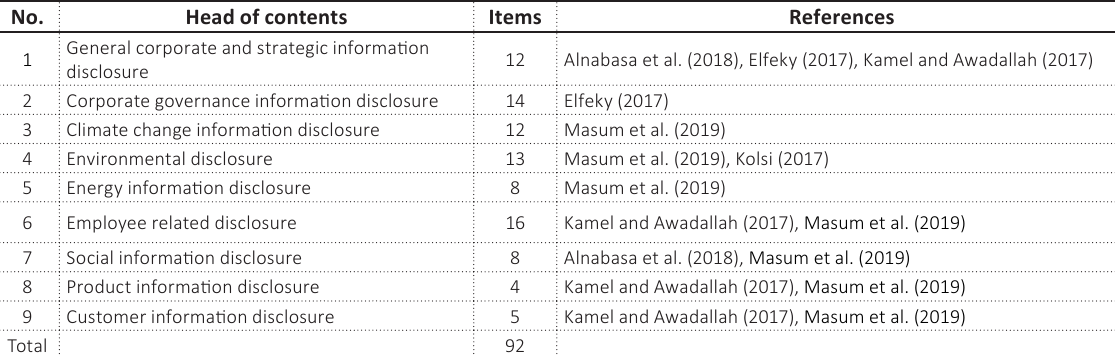
Table A1. Content analysis of corporate voluntary